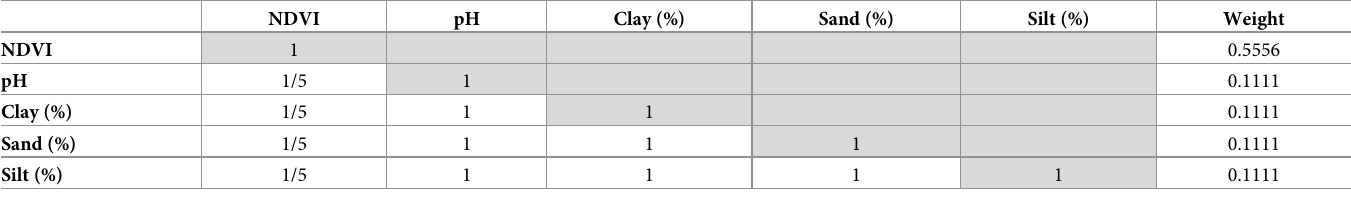
Table 7. Pairwise comparison matrix of the analytical hierarchy process (AHP) for the predictors associated with the occurrence of Psammomys obesus in Jordan. Based on the first author’s subjective judgement constructed from published